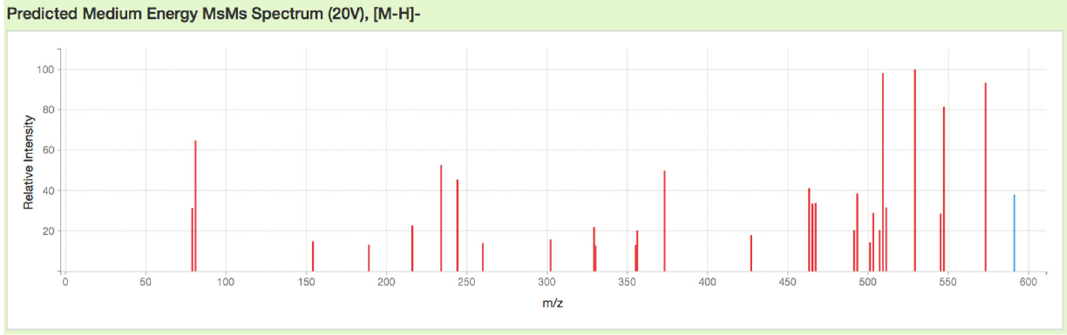
Figure 20. Predicted [M − H] − fragment ions for NODPAM using competitive fragmentation modelling software.